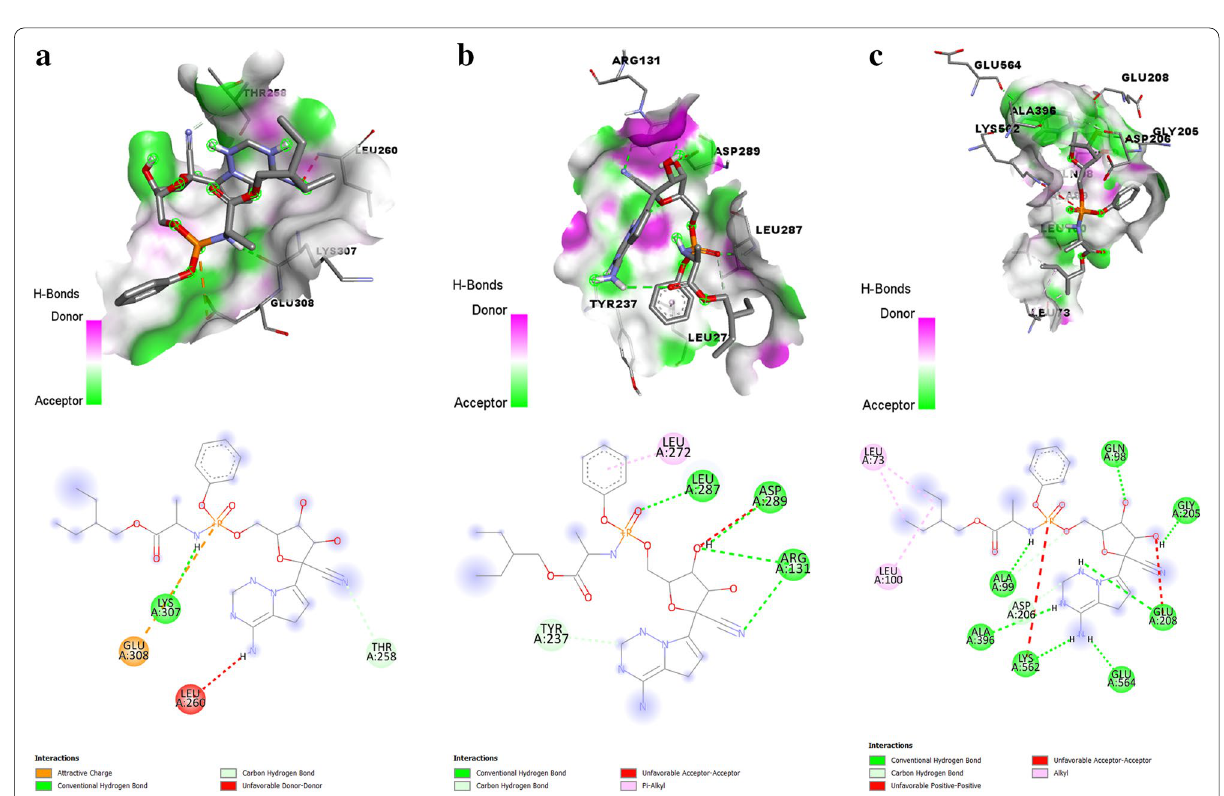
Fig. 6 Interaction of a Remdesivir with PLpro. b Remdesivir with 3CLpro. c Remdesivir with spike protein receptor binding